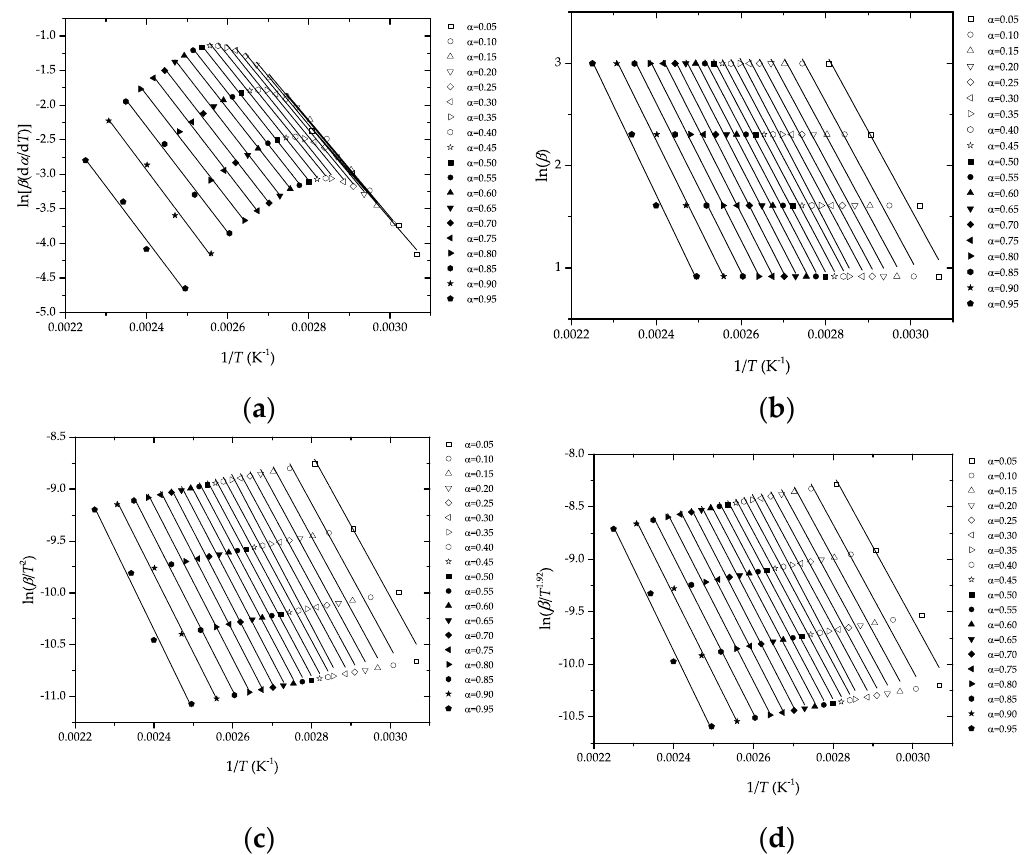
Figure 7. Characteristic plots of different isoconversional kinetic methods at different conversions α , corresponding to the crosslinking of a partially bio-based epoxy resin for different heating rates, β